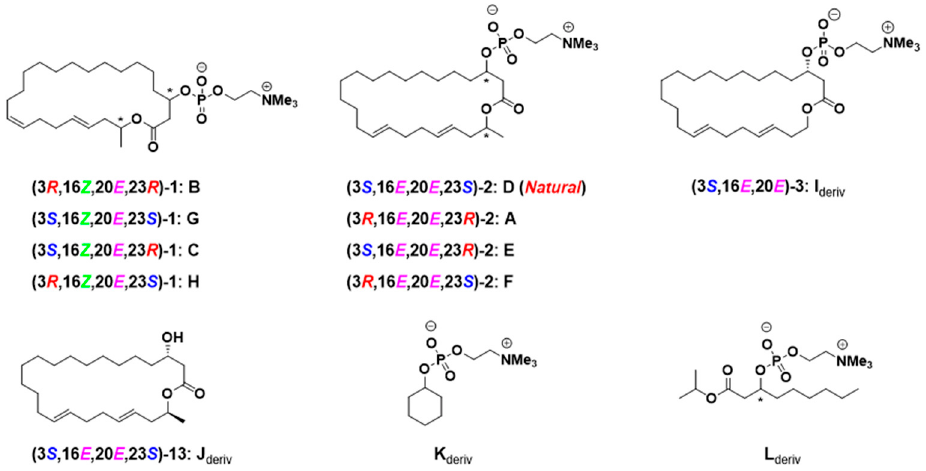
Figure 2. Structures and configurations of eushearilide congeners used for antimicrobial susceptibility testing.